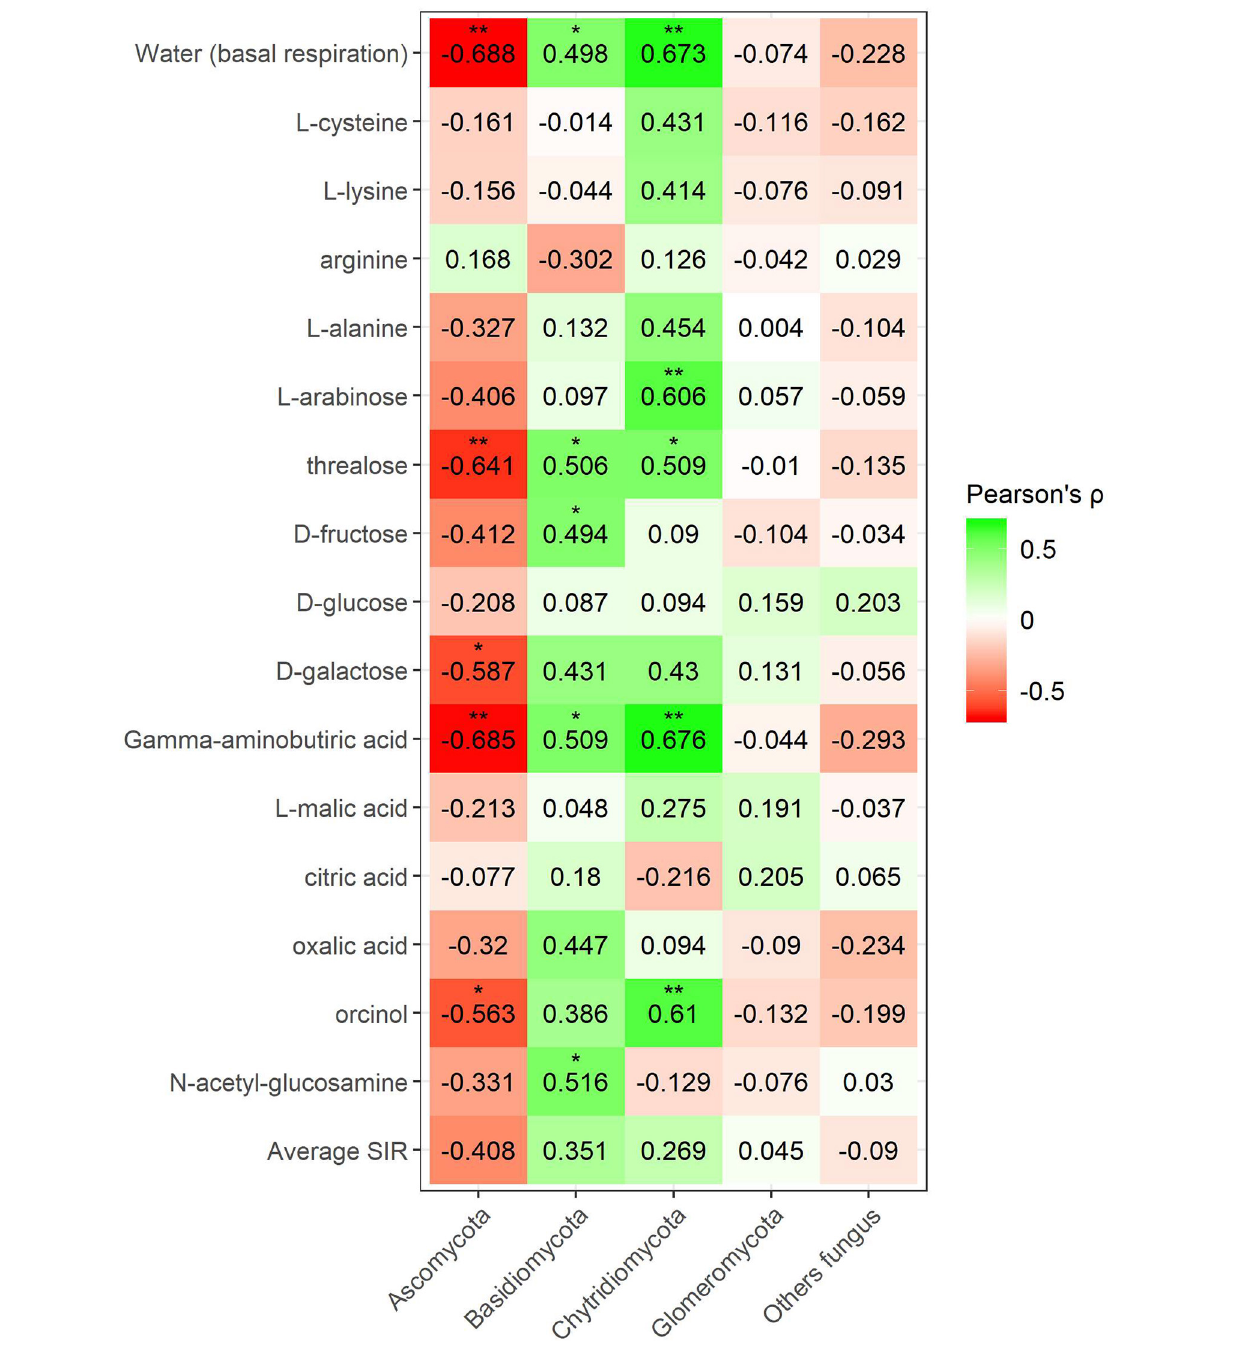
FIGURE 9 | Heatmap of Pearson’s correlation coefficient ( r ) between the most abundant bacterial phyla (mineral fertilization–soil effect) and the SIR results of the different carbon sources. Heatmap colors represent the Pearson correlations ranges, from red (negative correlation), passing through white (no correlation) to green (positive correlation). Significant results are indicated by an